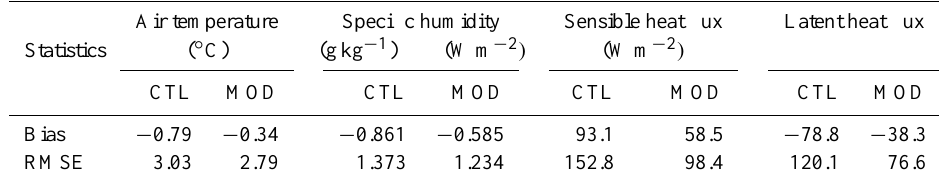
Fig. 4. Observations of air temperature and specific humidity at 2m above ground as well as sensible and latent heat fluxes of the CTL versus the MOD simulations. Table 1. Statistics of air temperature and specific humidity at 2m above ground as well as sensible and latent heat fluxes between the CTL and MOD simulations and the